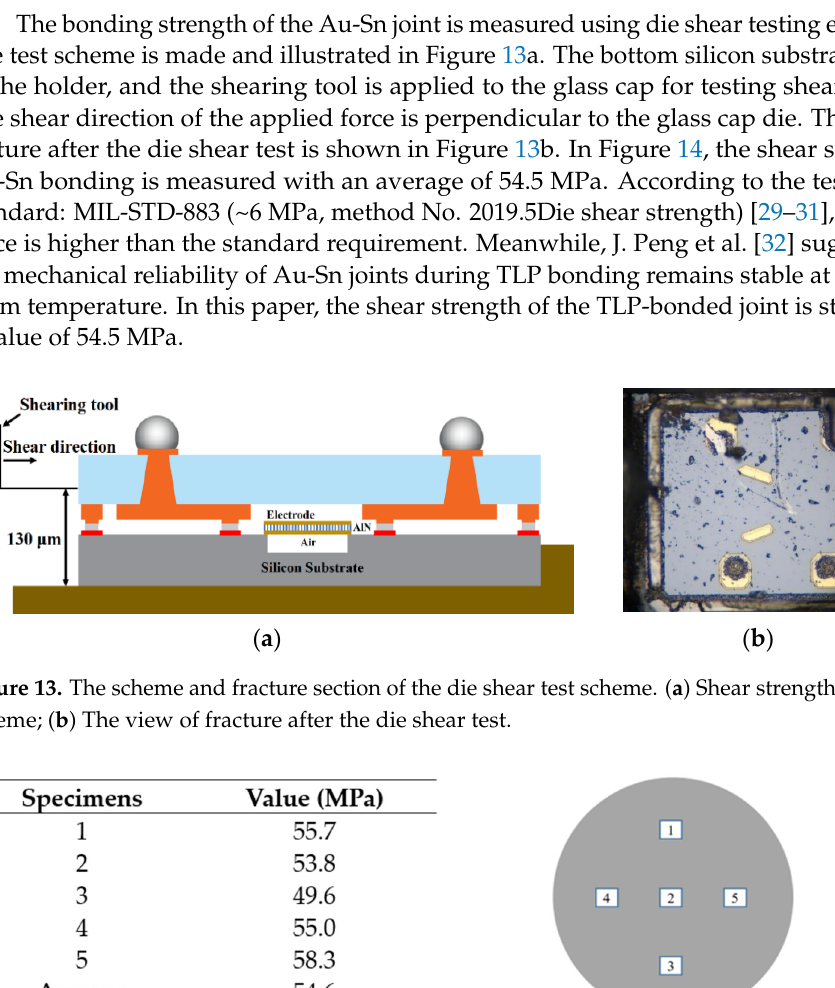
Figure 14. Shear strength test for RF filter WLP. ( a ) Shear force; ( b ) Measurement location.